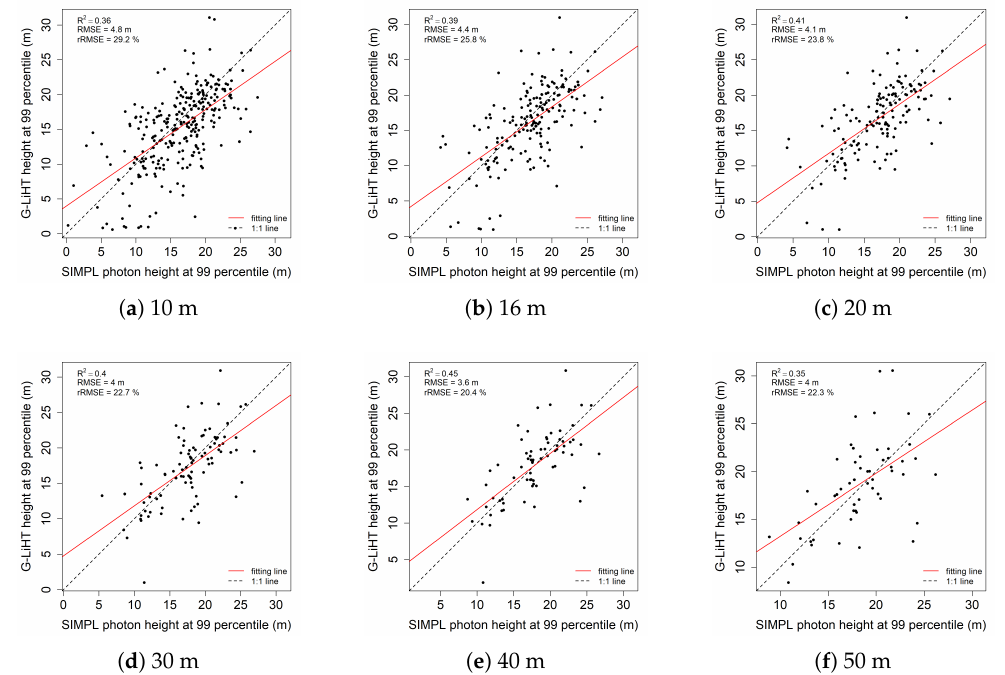
Figure 9. The relationship between the 99th percentile of all photon heights from SIMPL and the 99th percentile of all return heights from G-LiHT for different